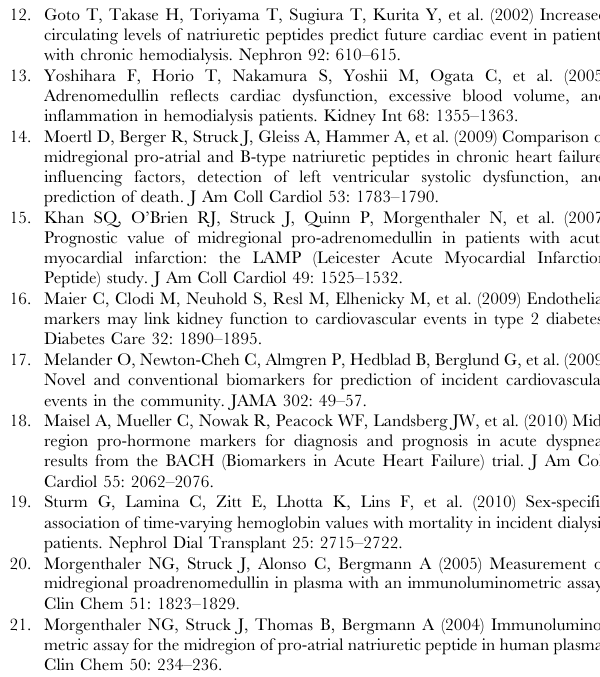
Table S1 The association of MR-proANP and MR-proADM as well as MR-proANP tertiles and MR-proADM tertiles and furthermore for patients with high risk (both MR-proANP and MR-proADM in the highest tertile) with different endpoints using multiple Cox-proportional hazards